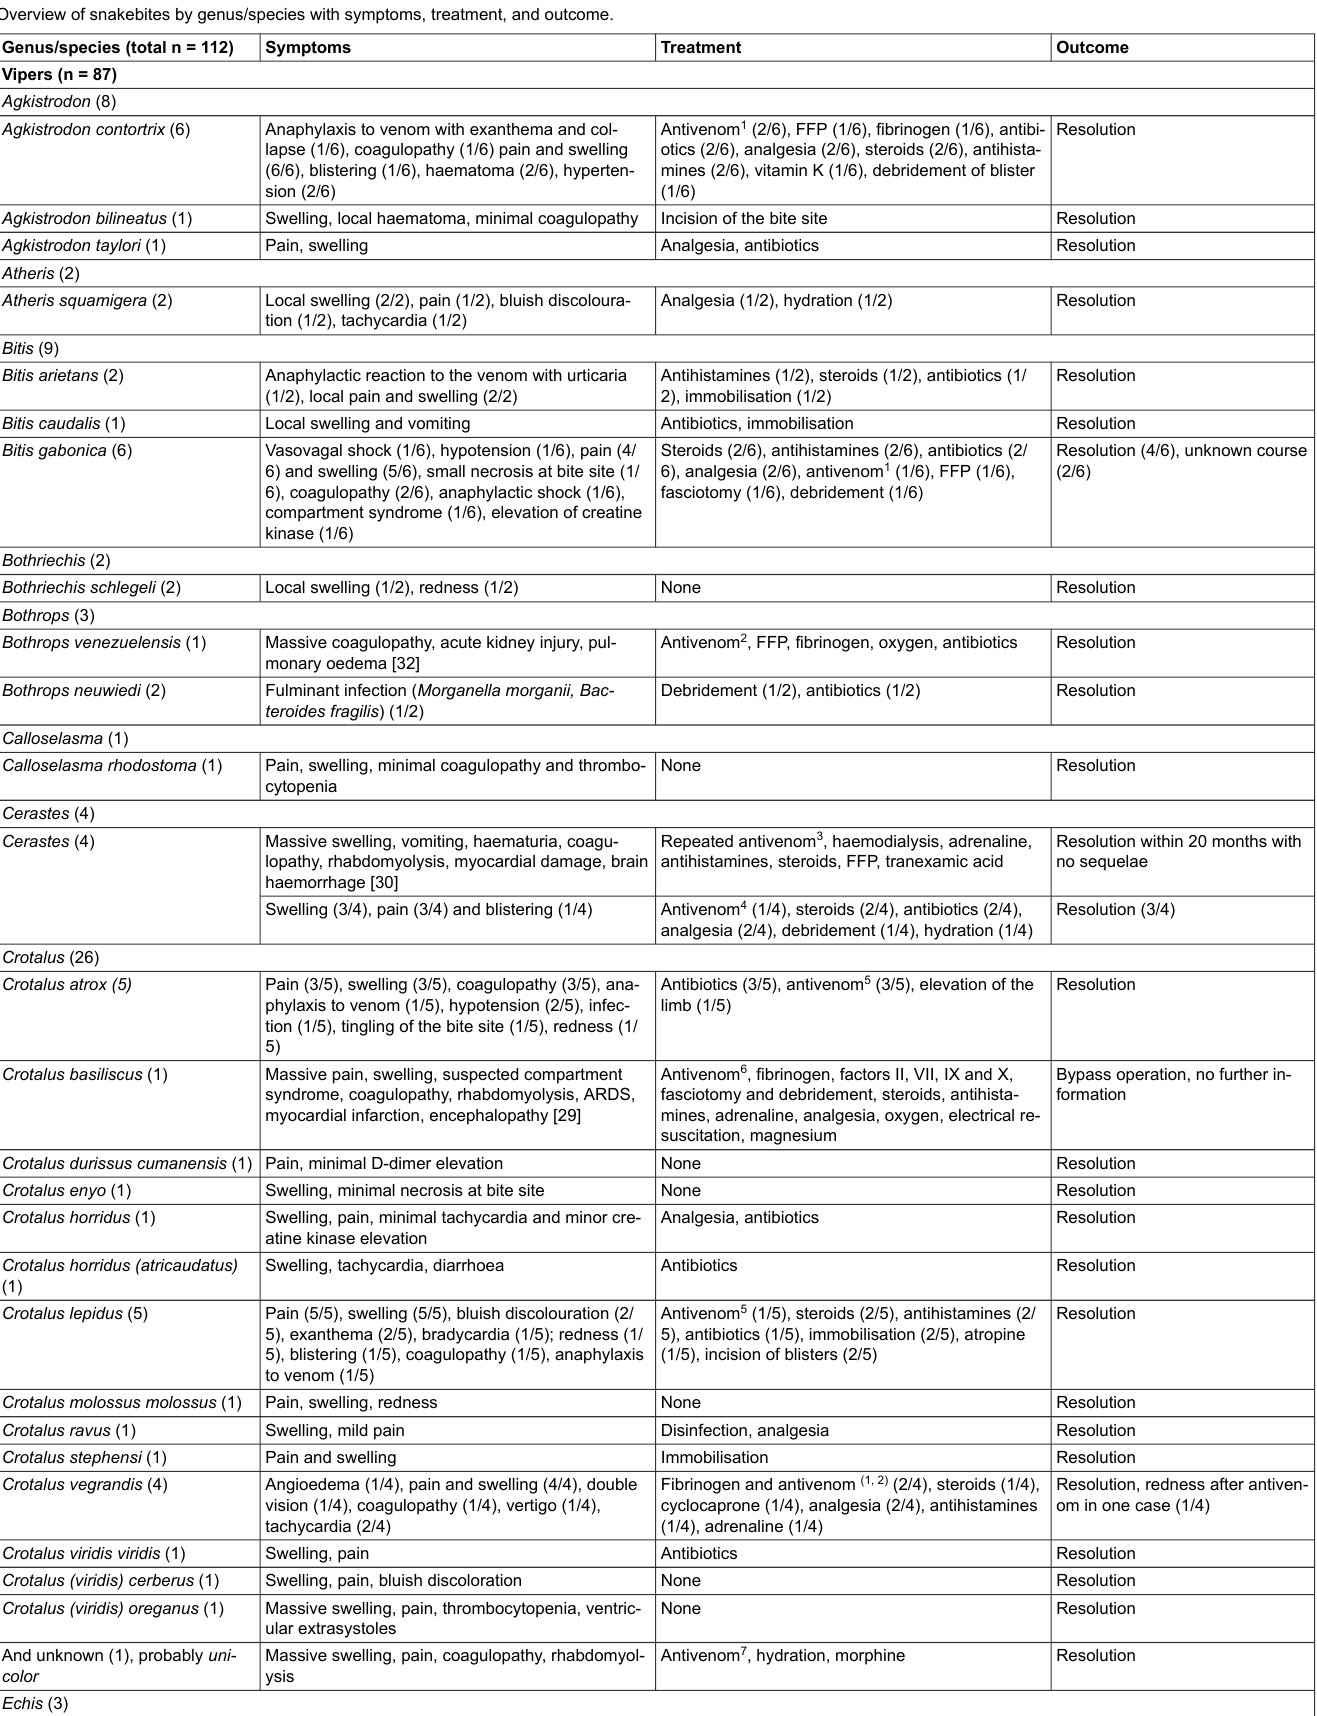
Table 4: Overview of snakebites by genus/species with symptoms, treatment, and